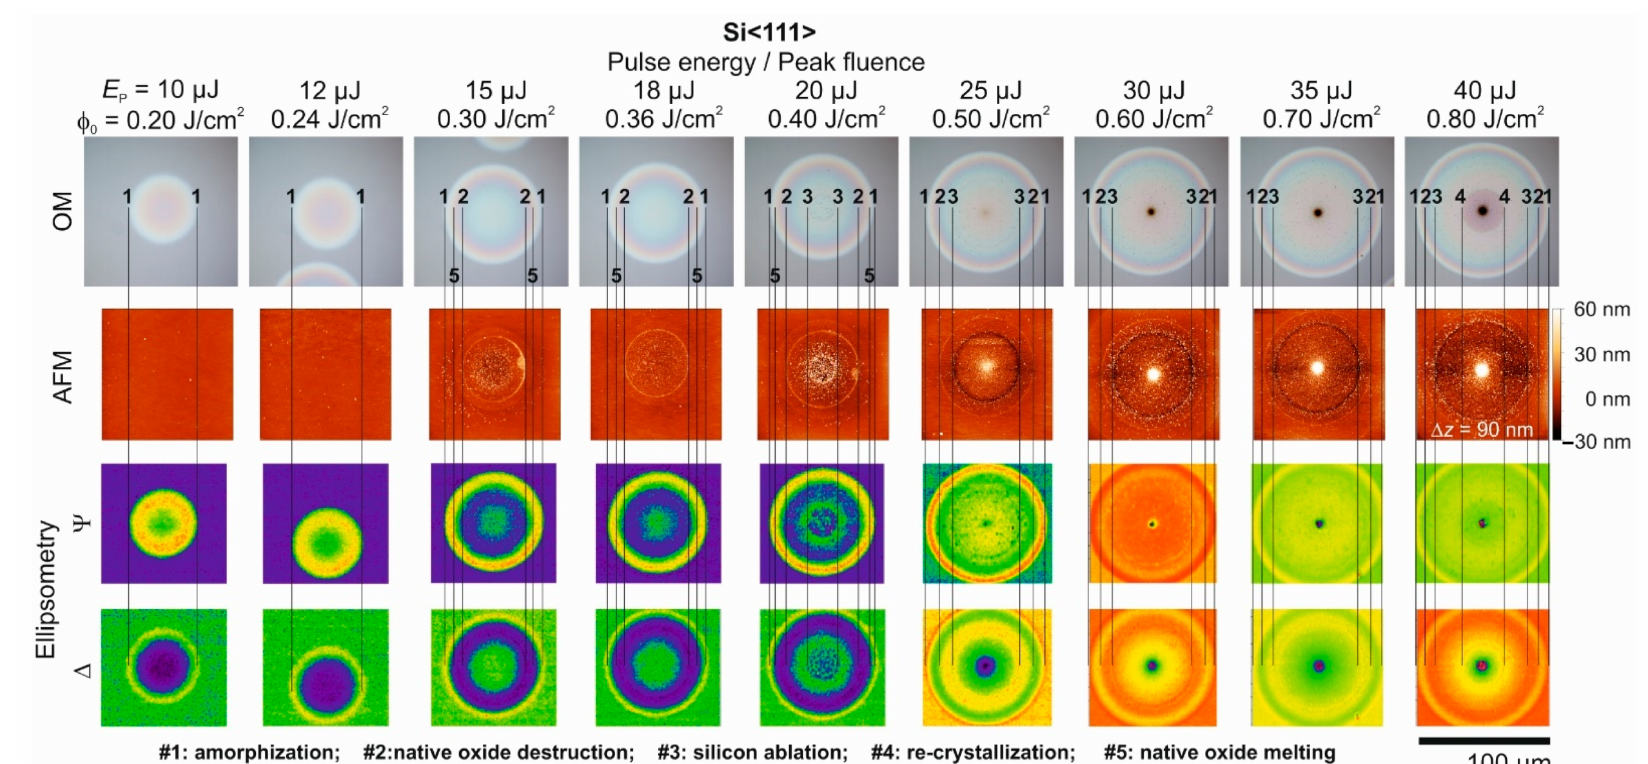
Figure 2. Comparison of brightfield optical microscopy (OM) images, atomic force microscopy (AFM) images, and corresponding spatial maps of the ellipsometric quantities Ψ and ∆ (taken at 637 nm wavelength) for a series of nine single fs-laser [ λ ~790 nm, τ = 30 fs] pulse-irradiated spots on a Si<111> wafer. The fs-laser pulse energy E p varies between 10 µ J and 40 µ J among the spots from left to right, corresponding to peak laser fluences between φ 0 = 0.20 and 0.80 J/cm 2 . The AFM images are provided in a common color scale, encoding height variations ∆ z of − 30 to +60 nm. The vertical (numbered) line sets mark the extent of characteristic surface features (for details see the text at the bottom of the figure). A common lateral scale bar is provided in the lower right